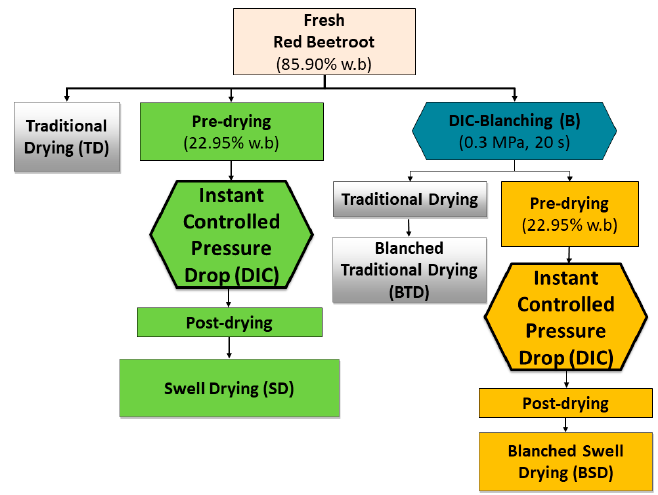
Figure 7. Schematic diagram of blanching, texturing, and drying treatments applied to red beetroots. The DIC equipment MP reactor consisted of three major components: (i) a double jacket processing vessel, (ii) a vacuum system, and (iii) the decompression system [30]. Figure 8 shows the schematic diagram of the DIC equipment reactor.